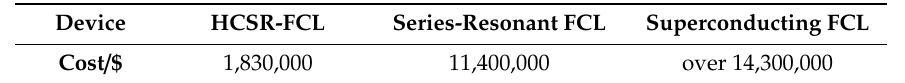
Table 3. Costs of the